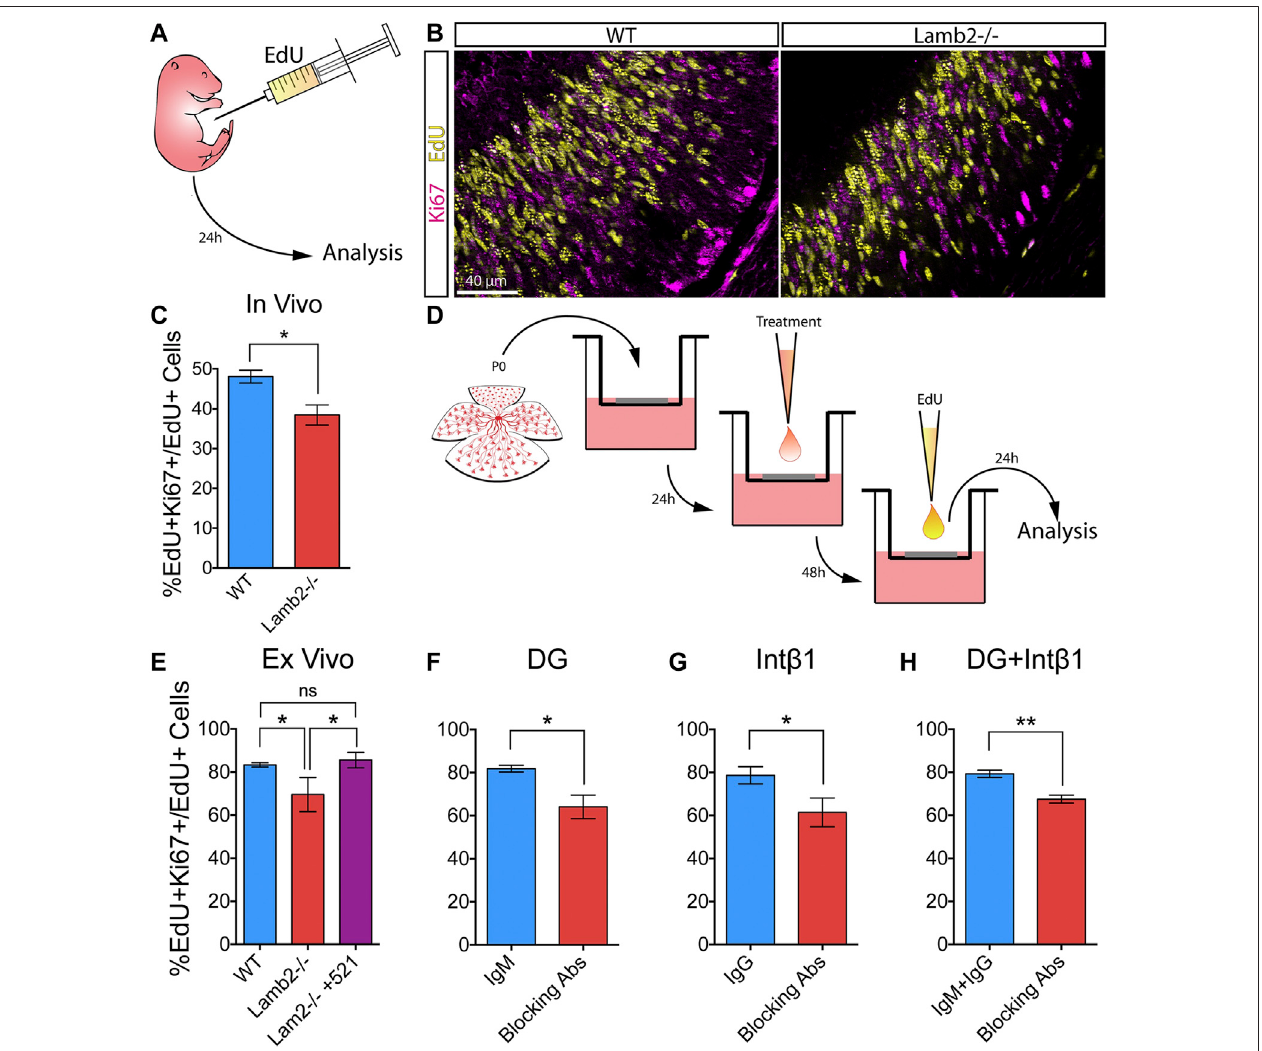
FIGURE6 | β 2-containing laminins regulate RPC cell cycle re-entry viaDG and int β 1. (A) . Experimental paradigmfor determiningthe rateofRPCcell cycle reentry. P3micewereadministeredasingleintraperitonealEdUinjection,andtheirretinaswerecollected24 hlater.Theresultantretinalcross-sectionswerethenstainedforEdU (proliferatingRPCsatP3)andKi67(proliferatingRPCsatP4)toassesstherateofRPCcellcyclere-entry. (B) .RepresentativeimagesofP4retinalcross-sectionsstained for EdU and Ki67. (C) . Quanti fi cation of EdU/Ki67 stained retinas. EdU+Ki67 + RPCs (RPCs that have re-entered the cell cycle) were signi fi cantly decreased in Lamb2 − / − retinas, compared to WT. (D) . Experimental paradigm for determining the rate of RPC cell cycle reentry in retinal explants. Explants were prepared from P0 retinasandgrownganglioncelllayerupintranswells.After24 h,adropofmediumcontainingeitherlaminin521,function-blockingantibodies,orcontrolantibodies,was added to the retinal surface. After 48h, medium containing EdU was added to the top compartment, and the retinas were collected 24 h later. The resultant cross- sections were then stained for EdU and Ki67. (E) . Quanti fi cation of EdU/Ki67 stained retinal explants. EdU+Ki67+ RPCs (RPCs that have re-entered the cell cycle) were signi fi cantly decreased in Lamb2 − / − explants, compared to WT. Addition of laminin 521 to Lamb2 − / − explants restored normal cell cycle re-entry. (F) . Blocking α -DG signalinginWTretinalexplantssigni fi cantlyreducedtherateofRPCcellcyclere-entry. (G) .Blockingint β 1signalinginWTretinalexplantssigni fi cantlyreducedtherateof RPC cell cycle re-entry. (H) . Blocking both α -DG and int β 1 signaling in WT retinal explants signi fi cantly reduced the rate of RPC cell cycle re-entry. Each data point represents the average of technical and biological experimental replicates ± SEM. Statistical analysis was performed using Student ’ s t-test. * — p ≤ 0.05. ** — p ≤ 0.01. NS — not signi fi